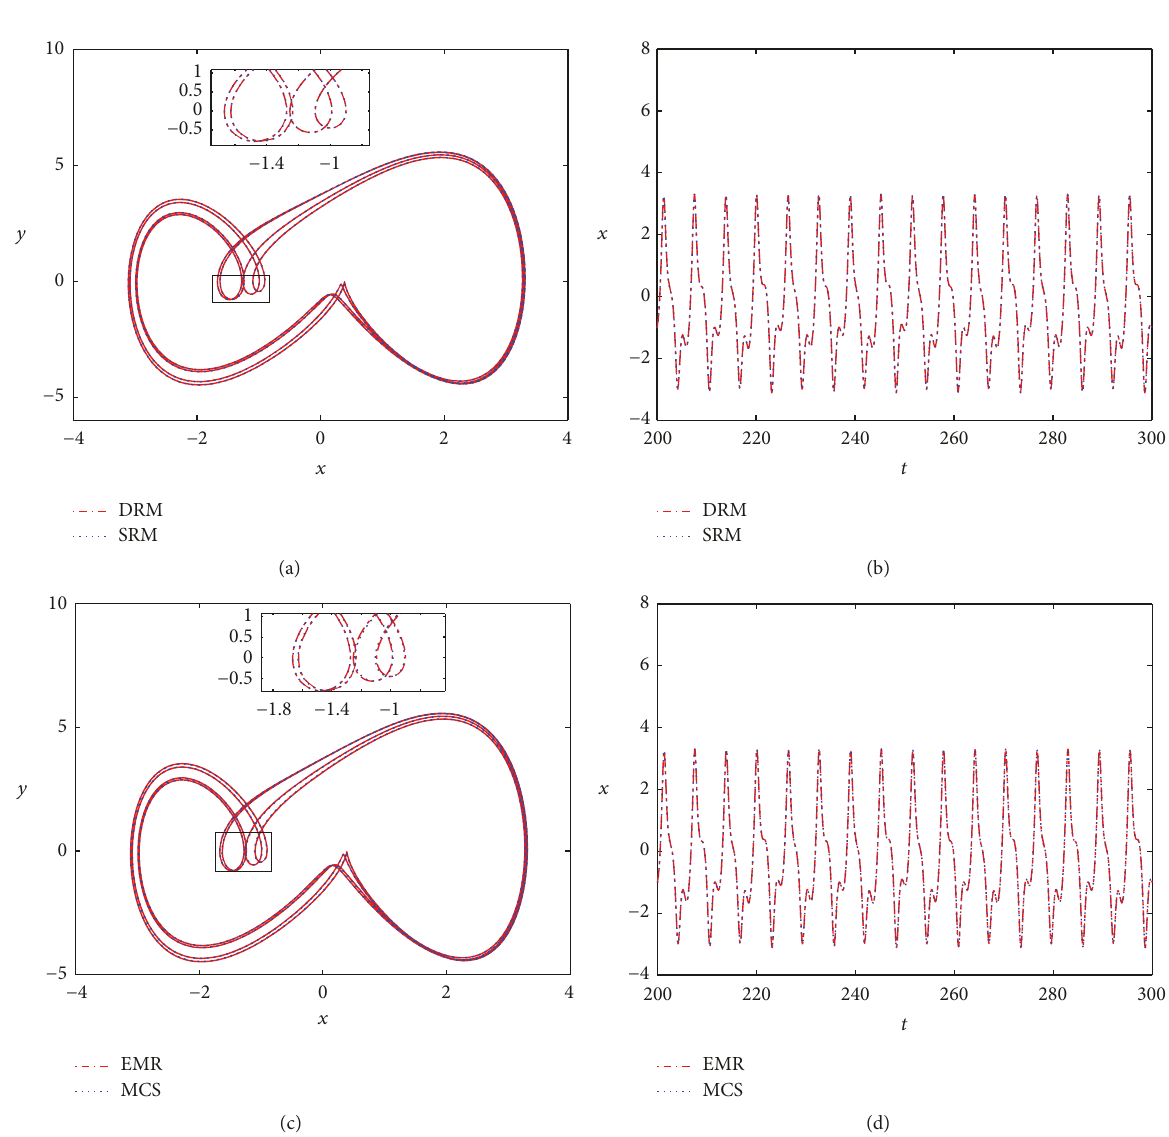
Figure 5: Period 4 𝑇 for 𝑞 = 0.9895 : (a) phase portrait for DRM-SRM; (b) time history diagram for DRM-SRM; (c) phase portrait for EMR- MCS; (d) time history diagram for EMR-MCS.